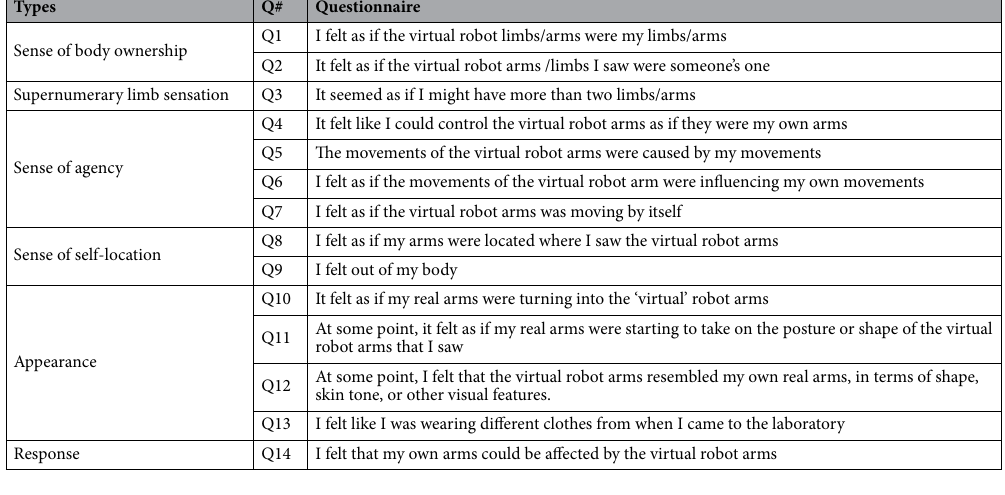
Table 1. Embodiment Questionnaire. Subjects were asked to rate the questionnaire on a 7-Likert scale. Six types of questions were prepared: Sense of Body Ownership, Supernumerary Limbs Sensation, Sense of Agency, Sense of Self-location, Appearance, and